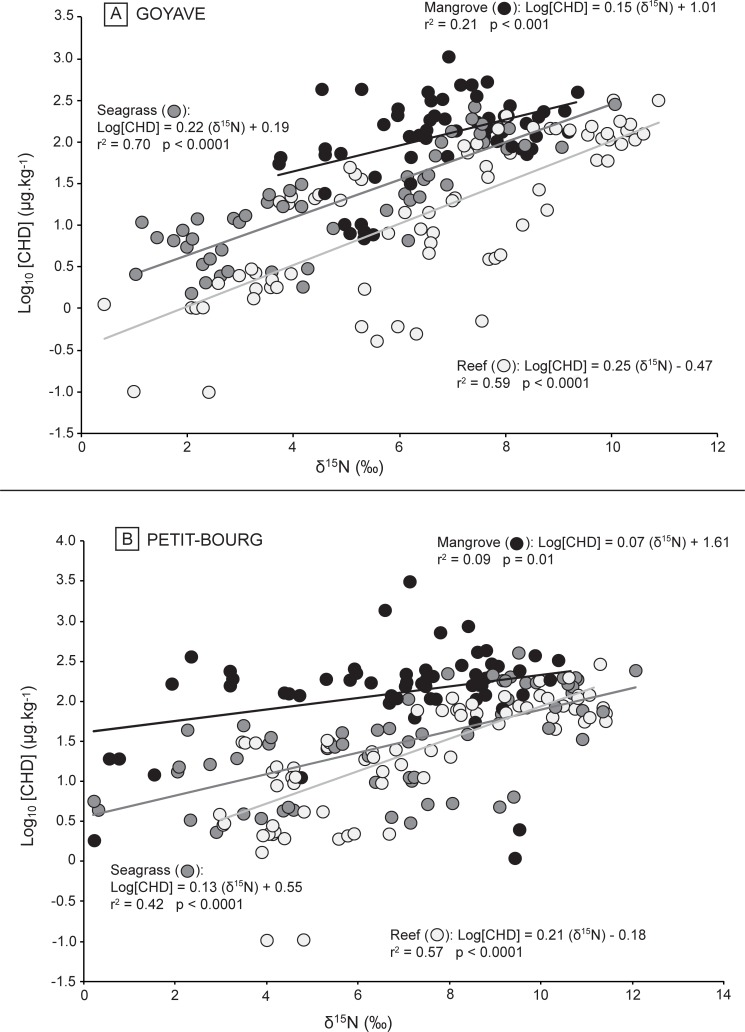
Relationships between logarithm of chlordecone concentrations (log10[CHD]) and nitrogen isotope ratios (δ15N).Organisms measured in mangrove (black circle), seagrass beds (grey circles) and coral reefs (white circles) at A) Goyave and B) Petit-Bourg.